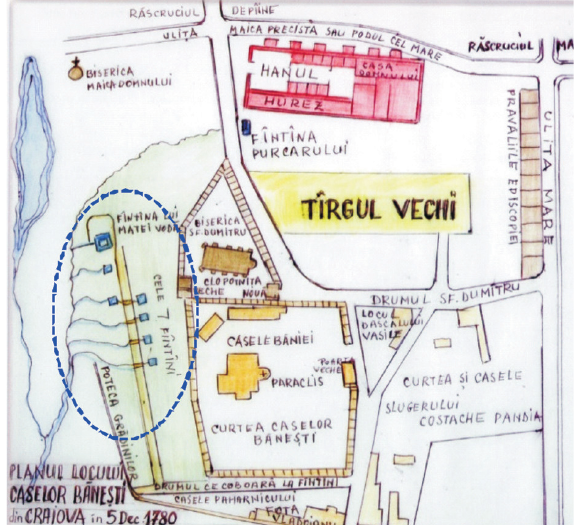
Fig. 4a. Sketch of Craiova in 1780 with the location of the 7 Wells ( Buce-Rădu ț 2008).